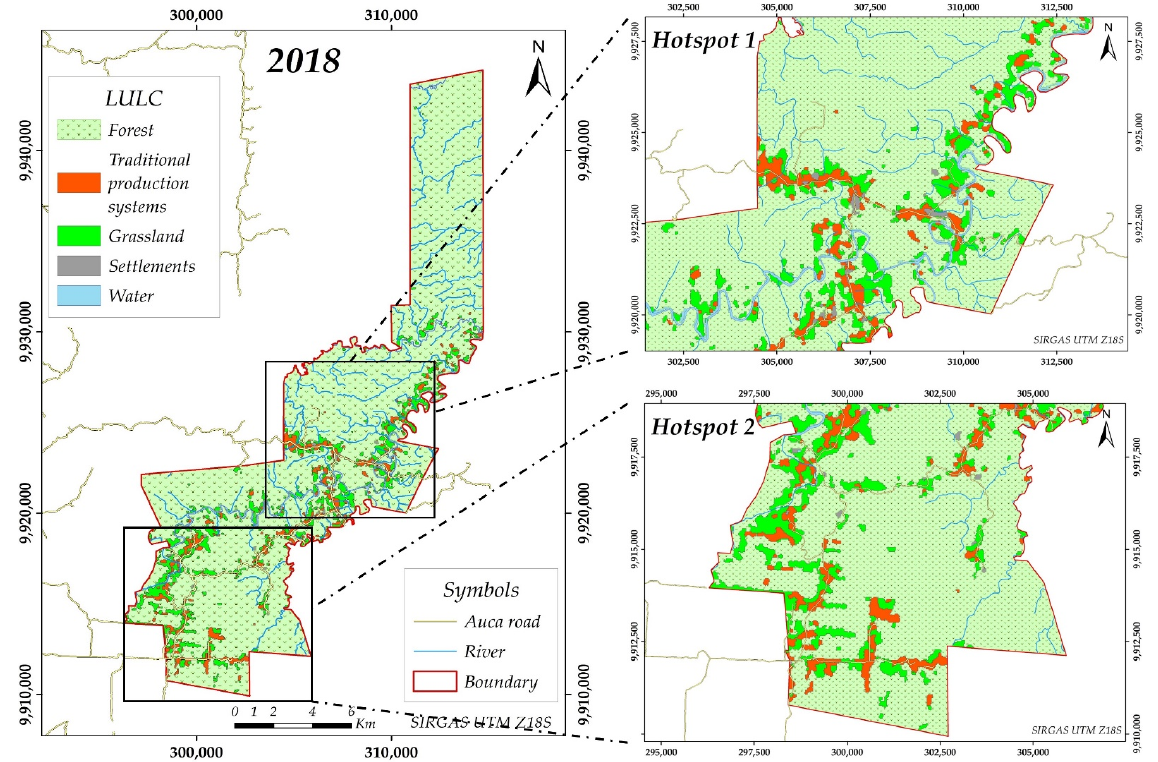
Figure 9. LULC hotspots in the northern zone of the DLZ (Dayuma and Taracoa) in the Yasuní Biosphere Reserve of the Ecuadorian Amazon Region.